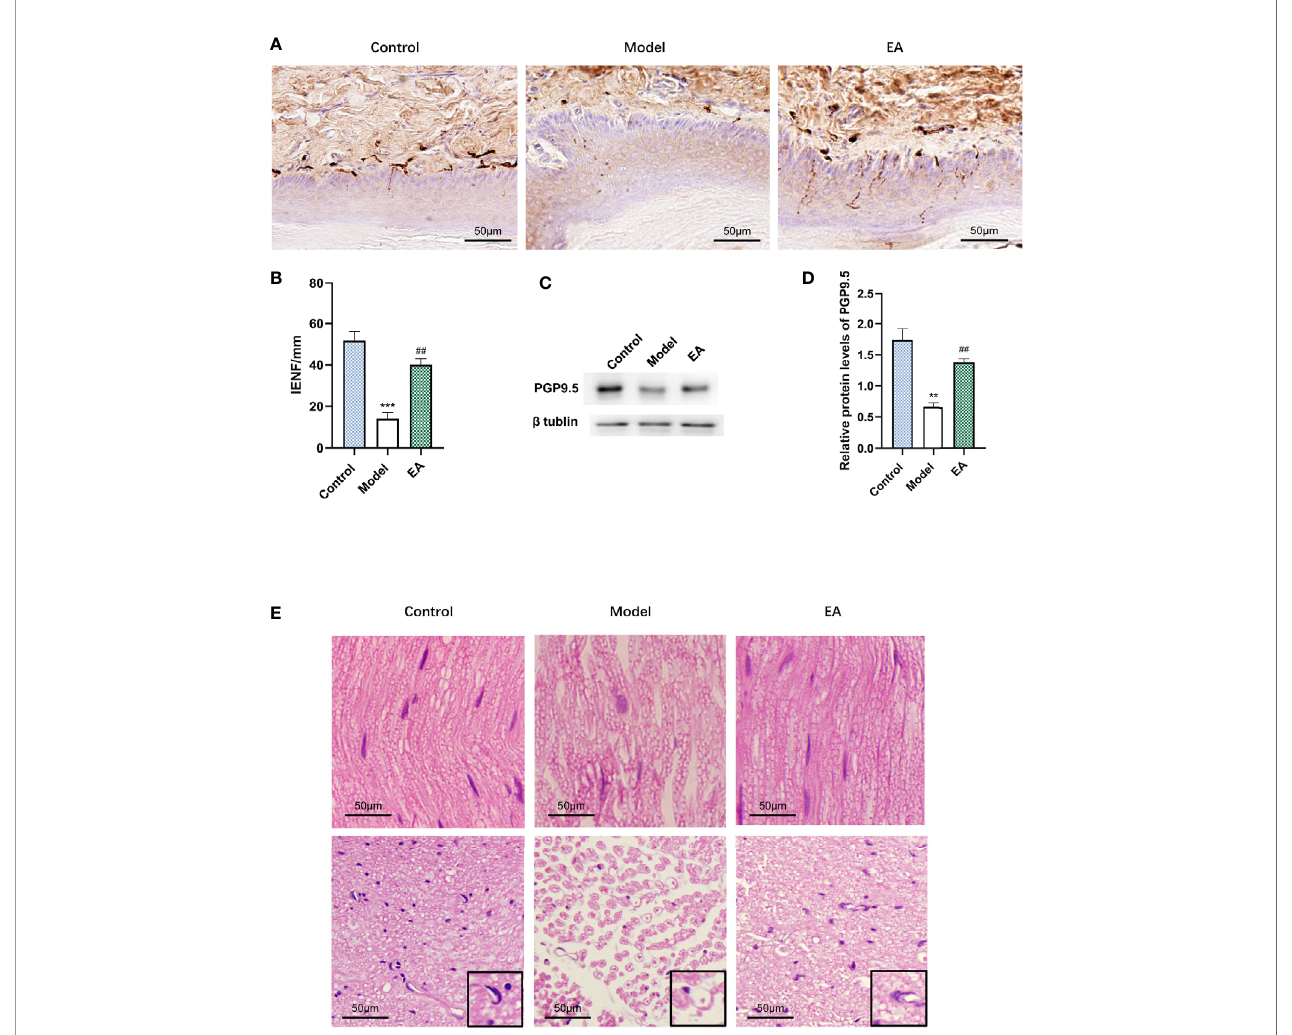
FIGURE 3 | Effect of EA on IENF, the expression of PGP9.5, and histopathology of the sciatic nerve. (A) Immunohistochemistry staining for PGP9.5 in hind paw skin of rats and (B) measurement of IENF (n = 3, ***p < 0.001, ## p < 0.01. Scale bar, 50 m m). (C) Representative Western blot analysis of PGP9.5 staining in footpad skin and (D) relative protein levels (n = 3, **p < 0.01, ## p < 0.01). (E) Morphological examination of paraf fi n-sectioned sciatic nerves performed at 12 weeks after STZ-HFD induction. A single nerve and its myelin sheath were observed in a high-power microscope (×400). (n = 3, scale bar, 50 m